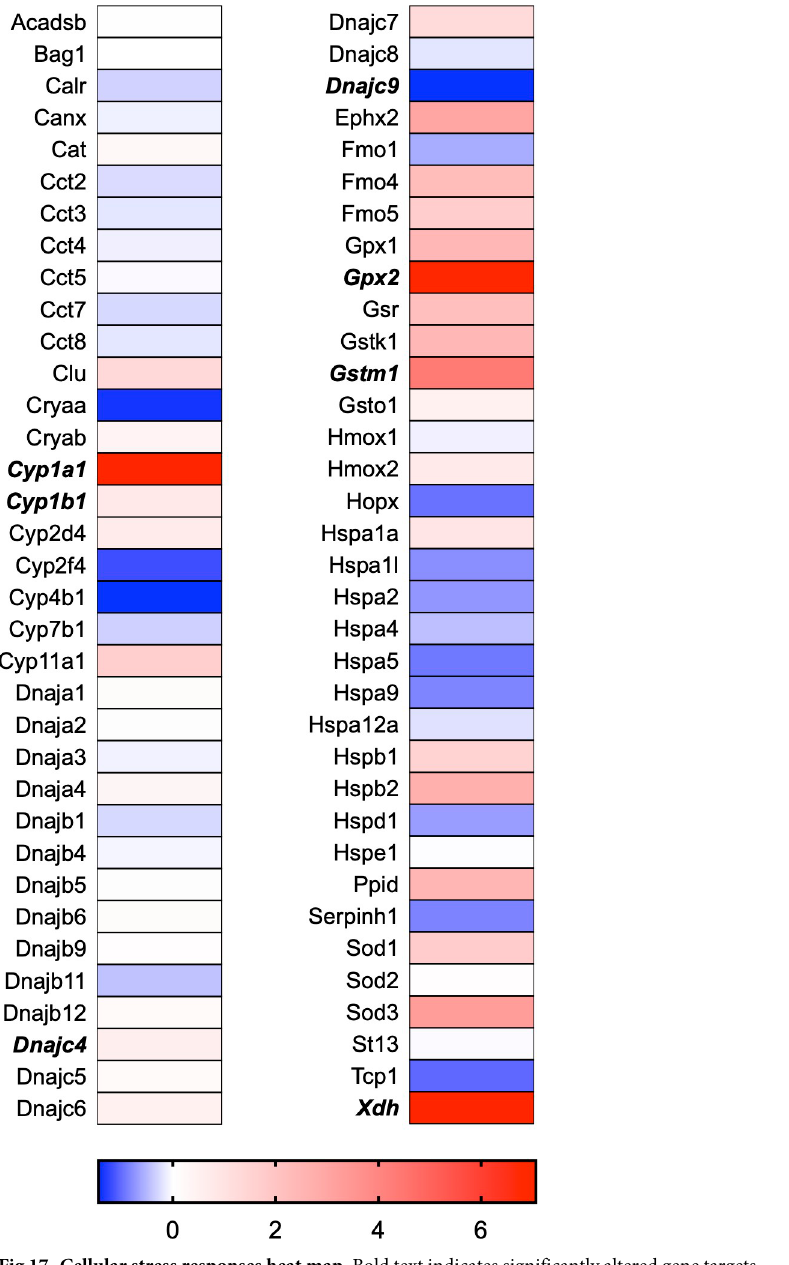
Fig 17. Cellular stress responses heat map. Bold text indicates significantly altered gene